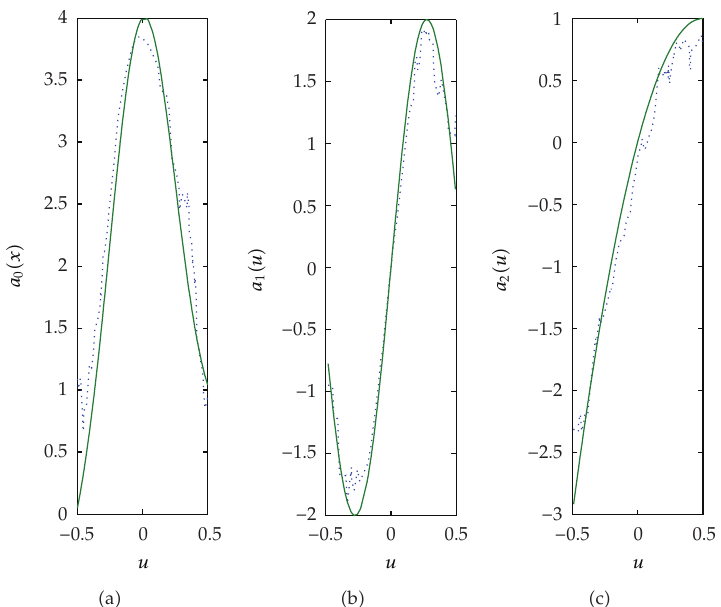
Figure 3: Simulation results, for example, with outliers. Dotted curves are L 1 estimators; solid curve are the true